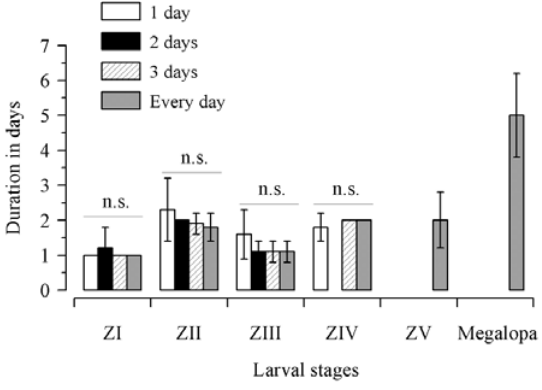
Fig. 2 – Zoeal and megalopal stage duration (in days, average ± stan- dard deviation) of Callichirus major submitted to an initial period of feeding. Larvae were fed for 1 day only (Treatment 1); Larvae were fed for 2 days (Treatment 2); Larvae were fed for 3 days (Treatment 3); Larvae were fed every day (Control treatment). n.s. = non significant differences among treatments. ZI–ZV = zoeal larval